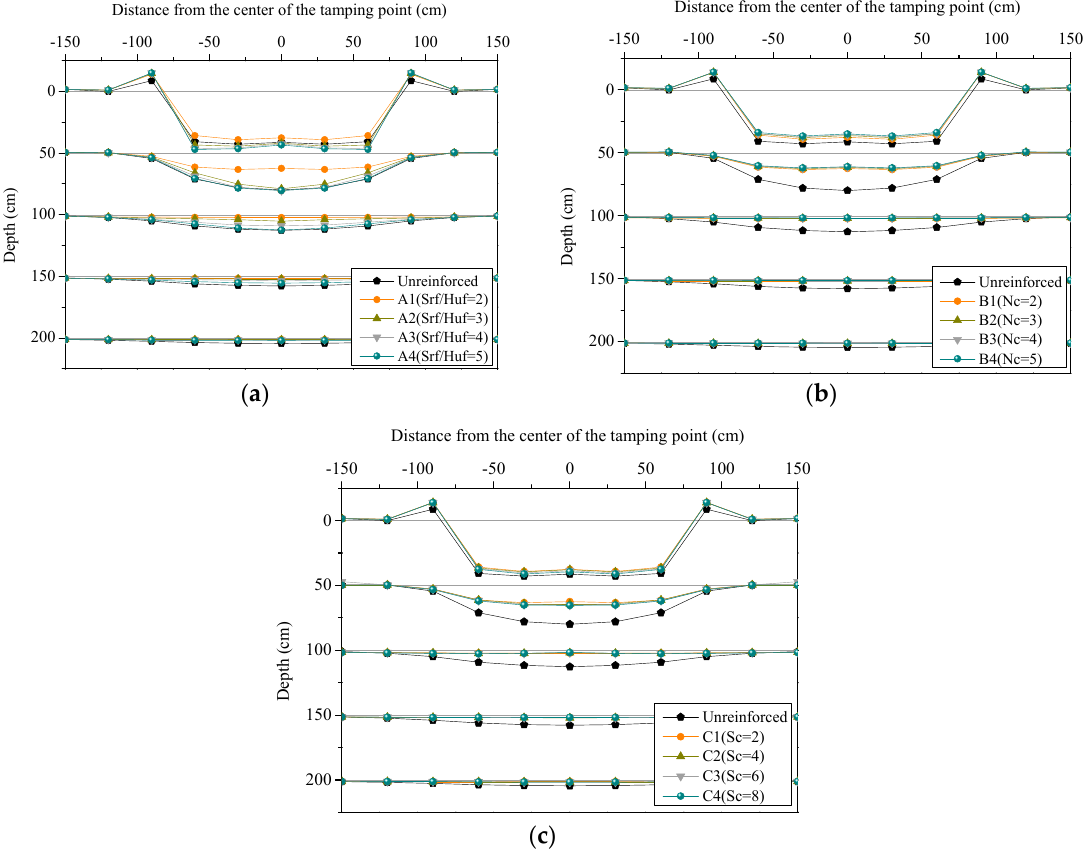
Figure 3. The vertical displacement under three factors: ( a ) embedded ratio; ( b ) number of reinforced layers; ( c ) interval of reinforced layers.